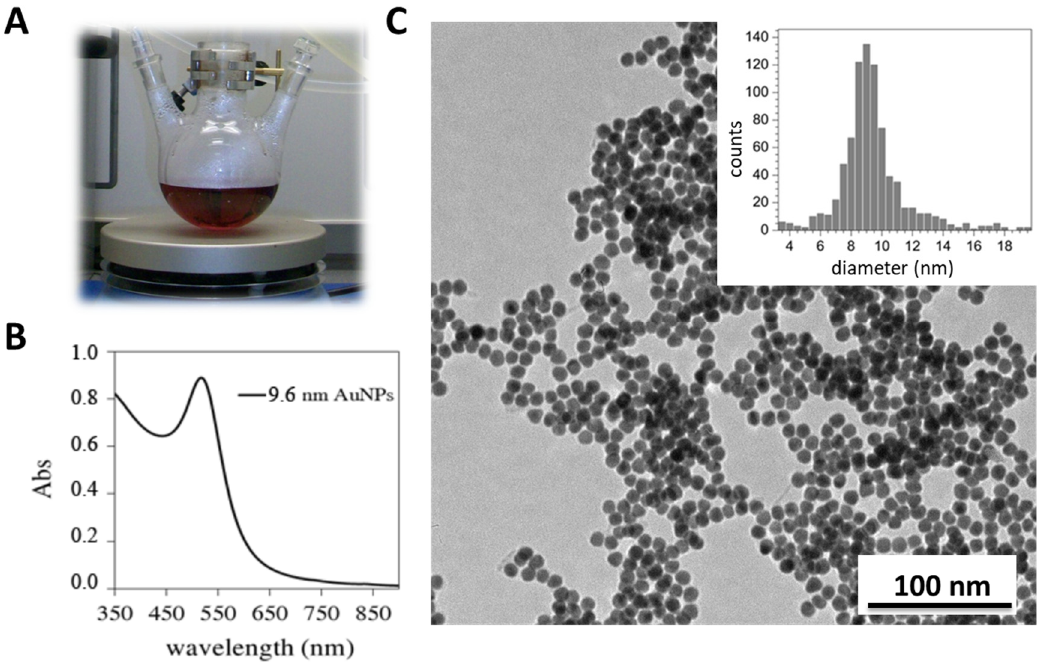
Figure 2. Synthesis of 9.6 nm gold nanoparticle: ( A ) reduction in tetrachloroauric acid in the presence of a reducing agent (citrate) to form colloid AuNPs (red solution); ( B ) UV–Vis absorption spectra of AuNPs with an absorption peak at 517.5 nm; and ( C ) TEM images of AuNPs and their respective size distribution histograms.